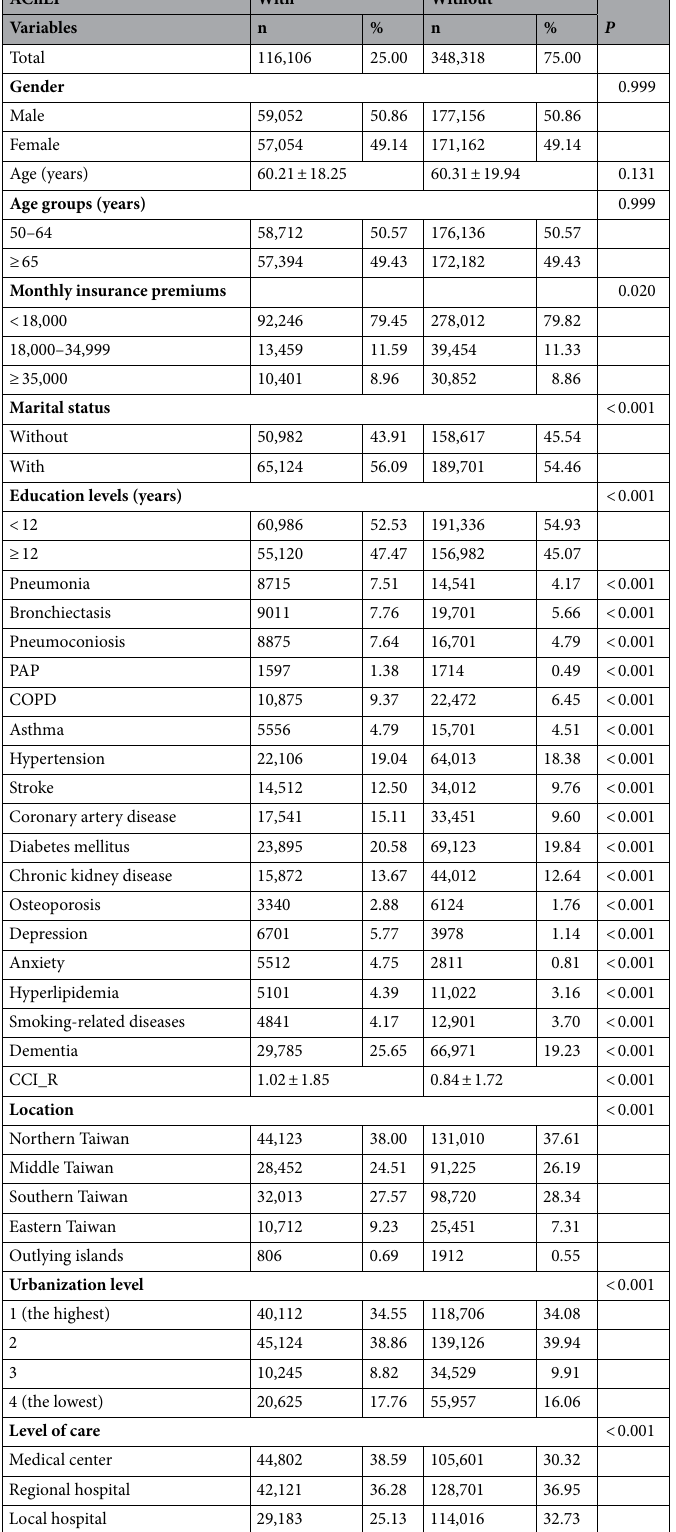
Table 1. Characteristics of study at the baseline. P : Chi-square/Fisher exact test on category variables and t test on continue variables. AChEI acetylcholinesterase inhibitors, CCI_R Charlson Comorbidity Index, dementia removed, COPD chronic obstructive pulmonary disease, NT$ New Taiwan Dollars, PAP pulmonary alveolar